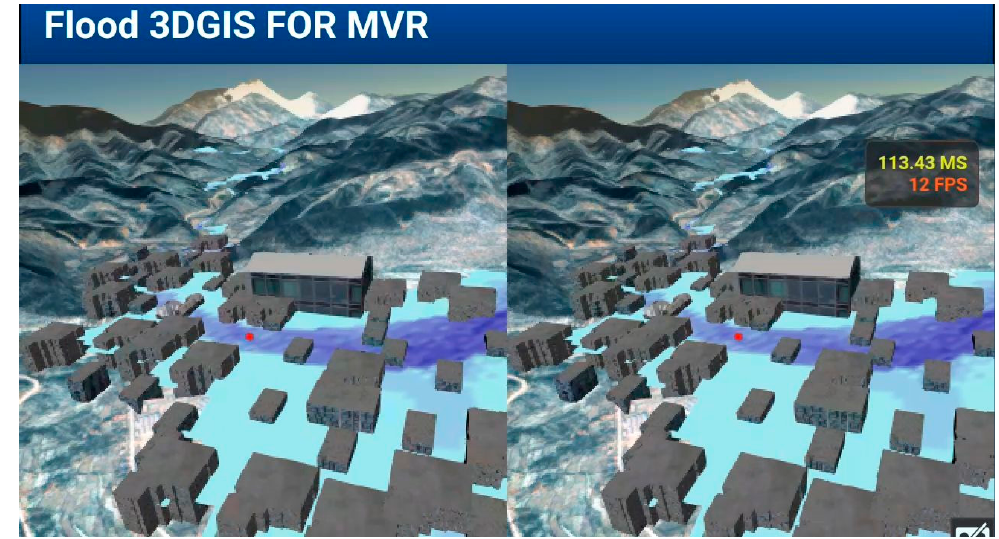
Figure 2. Screenshot of the prototype system on a smartphone.